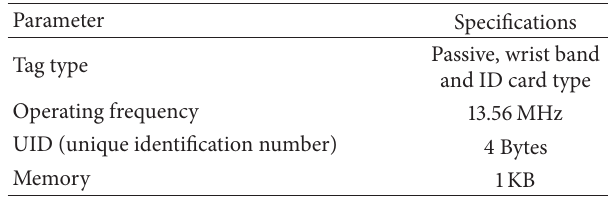
Table 2: Technical specifications of RFID tag used in our